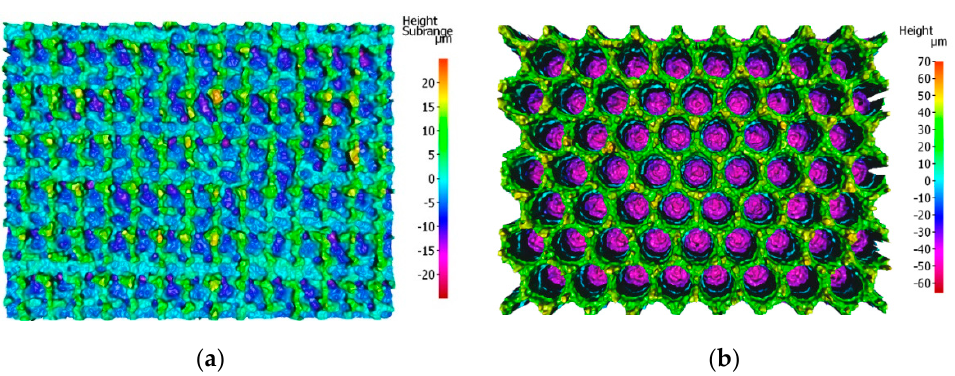
Figure 7. Figure shows the topography of laser structures with ( a ) 50 µm and ( b ) 80 µm spot-to-spot spacing.